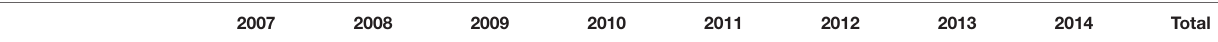
TABLE 3 | Distribution by years, of the ratio of health expenditures by categories to total expenditures in households with catastrophic health